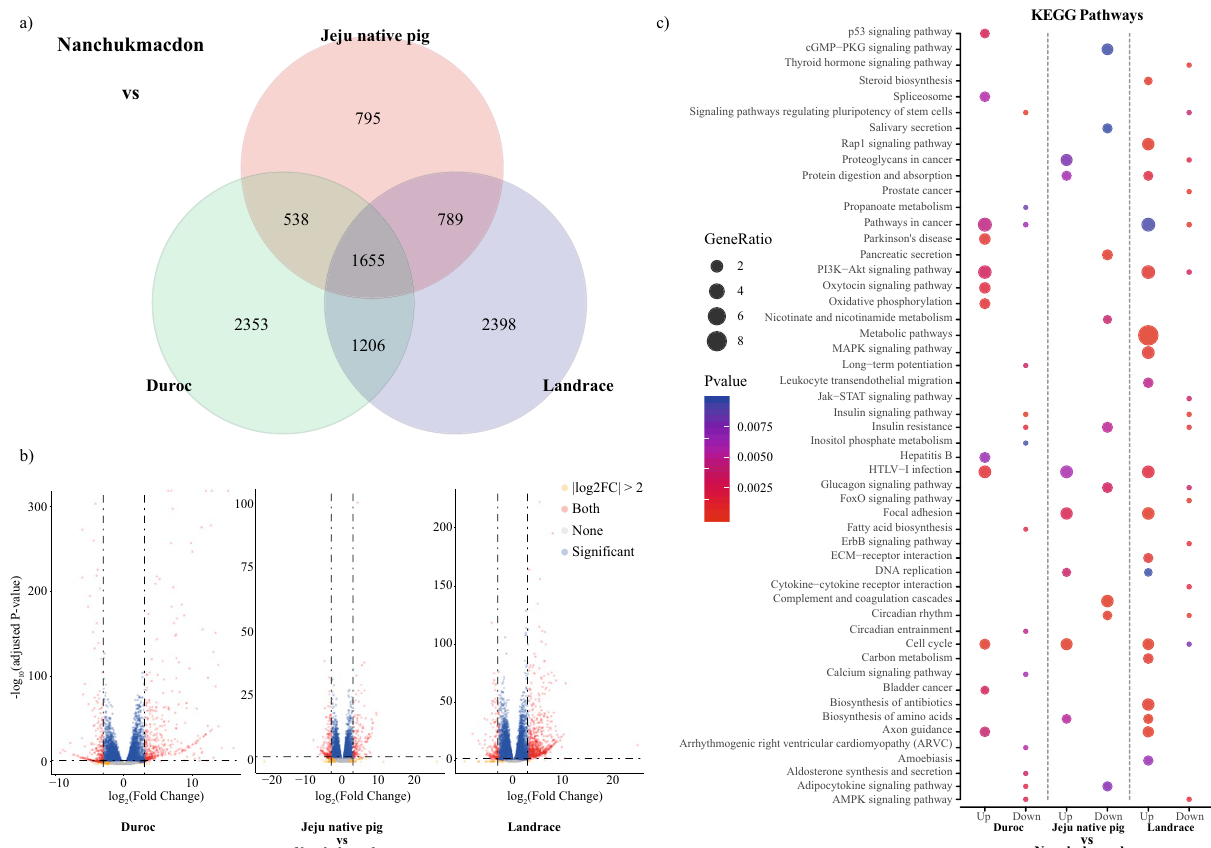
Figure 2. Result of RNAseq analysis of Nanchukmacdon with Duroc, Jeju native pig and Landrace. ( a ) Commonly identified differentially expressed genes. ( b ) Volcano-Plot for distribution of adjusted p-value with log2foldchange for DEGs analysis in muscles against Duroc, Black pig and landrace with Nanchukmacdon respectively and ( c ) KEGG pathway enrichment analysis after functional annotation with p < 0.01. Enriched pathway in Nanchukmacdon from the different breed was performed by dot-plot